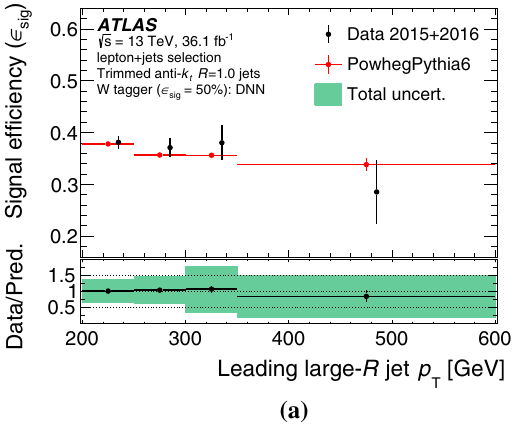
Fig. 18 The signal efficiency on contained W -boson jets for the jet shape-based DNN W -boson tagger as a function of the large- R jet p T ( a ) and the average number of interactions per bunch crossing μ ( b ) in data and simulation. Statistical uncertainties of the signal efficiency measurement in data and simulation are shown as error bars in the top panel. In the bottom panel, the ratio of the measured signal efficiency